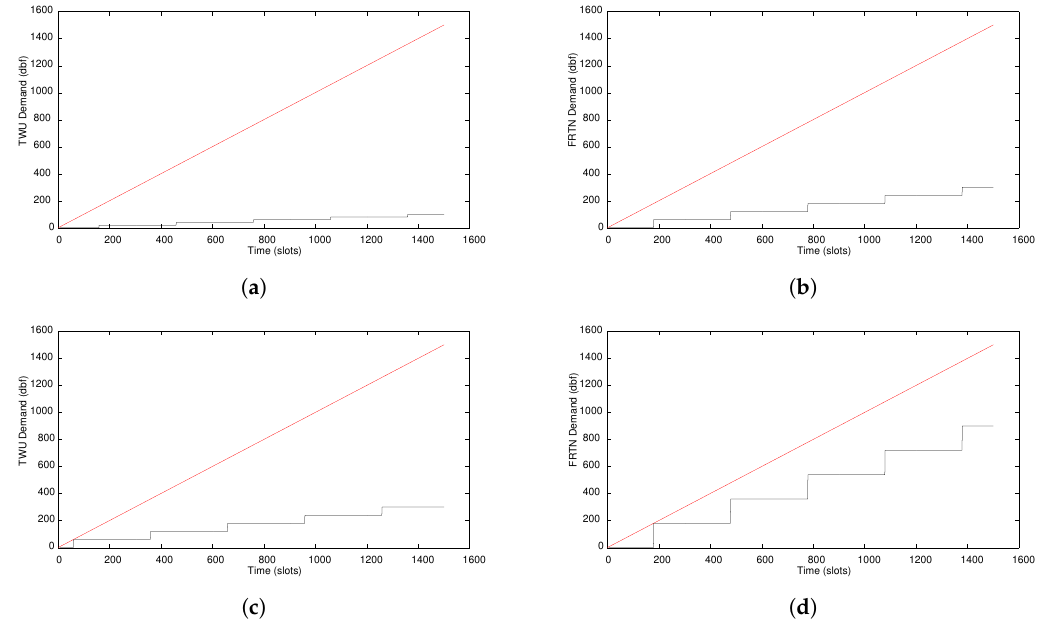
Figure 11. Demand bound function ( dbf , in black) and t bound (in red) in the TWU and the mules. ( a ) TWU with 10 messages; ( b ) Mule involving 30 messages; ( c ) TWU with 30 messages; ( d ) Mule involving 90